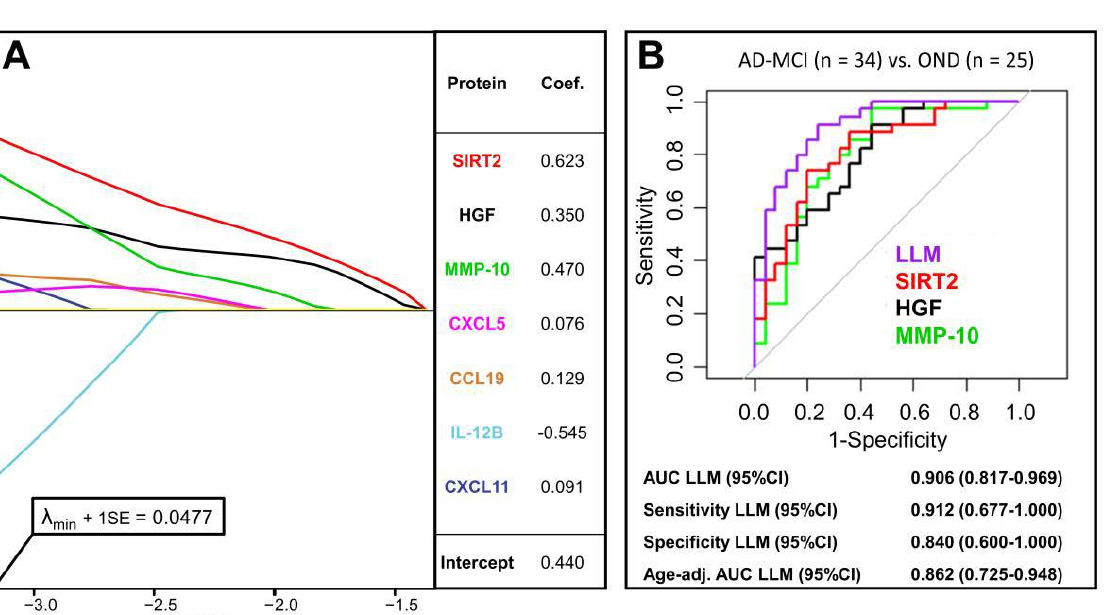
6 of 12 Figure 1. Correlation heatmap. Correlation coefficients were computed according to Spearman. Hierarchical clustering was used for ordering proteins by using correlation coefficients as distance